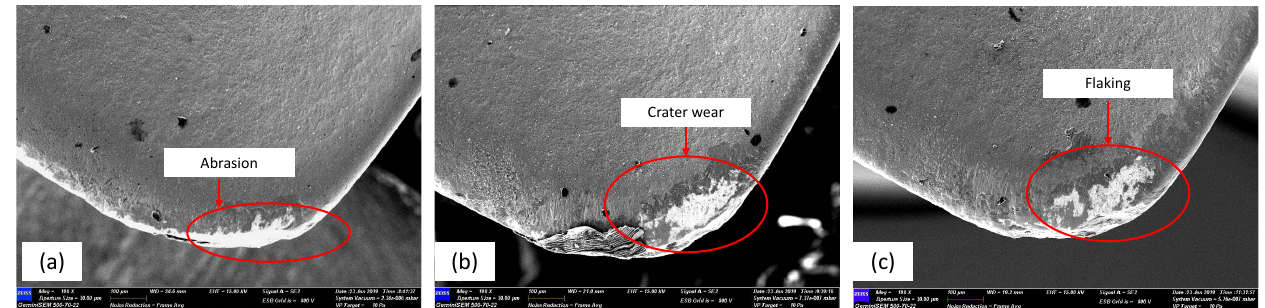
Figure 3. Tool wear in rake face: ( a ) Abrasion wear in Experiment 1; ( b ) Crater wear in Experiment 6; ( c ) Flaking in Experiment